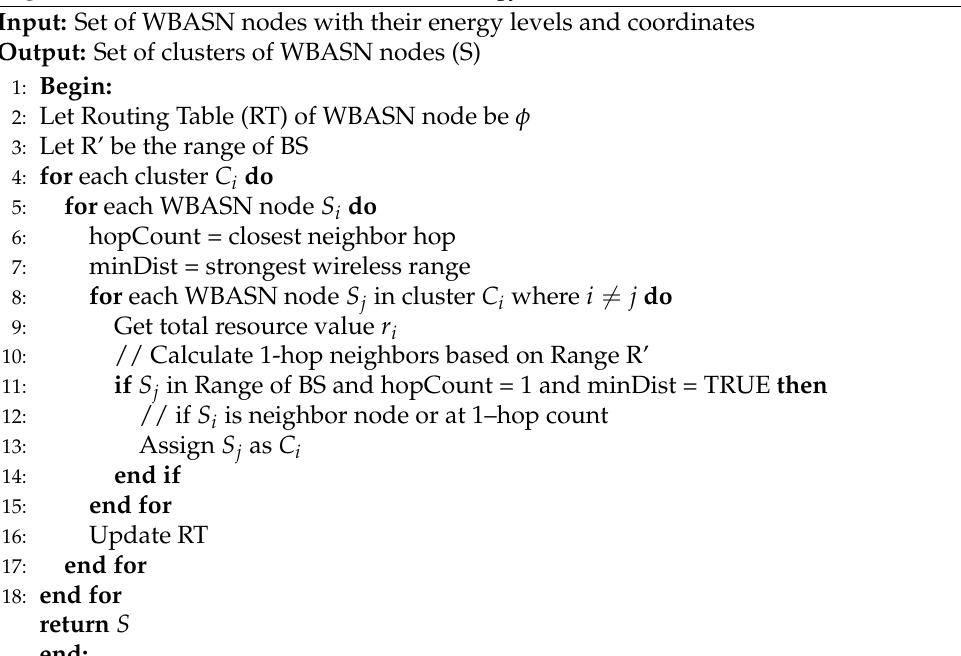
Algorithm 1 Cluster formation based on energy level and shortest